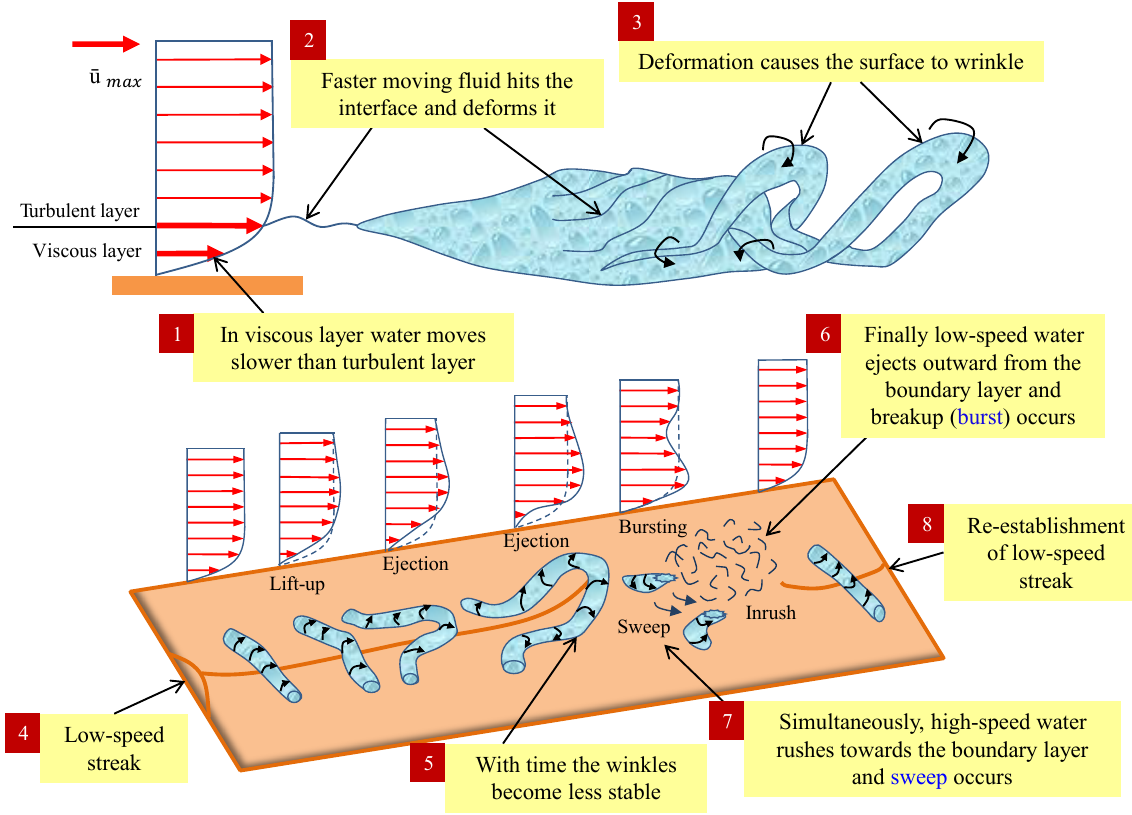
Figure 1. Schematic diagram of the typical sequence of turbulent bursting phenomena (Allen, 1985; Robinson, 1991; Bridge, 2003) where the flow is directed from left to right and the arrow length represents the relative velocity in the velocity